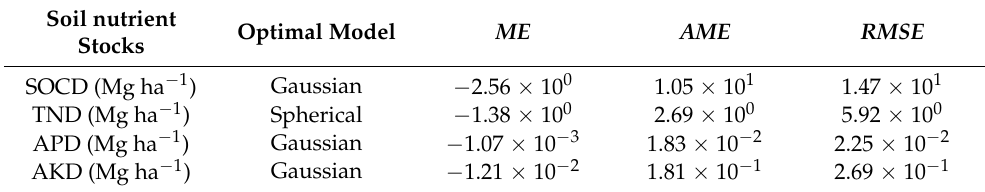
Table 3. Cross-validation of OK interpolation for SOCD, TND, APD, and AKD at 0–60 cm.